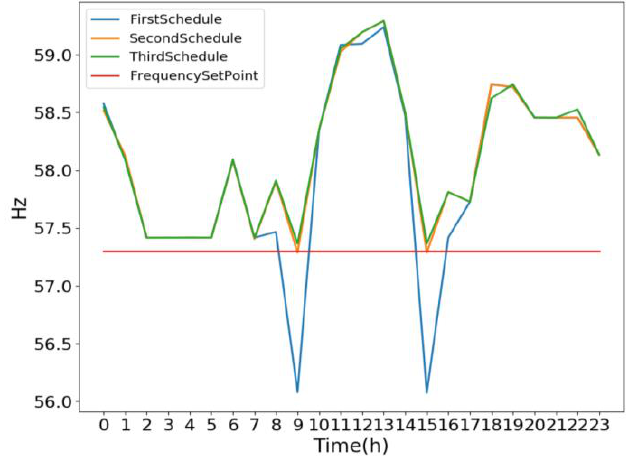
Figure 10. Minimum frequency of N-1 contingency per hour for three schedules of case 1.